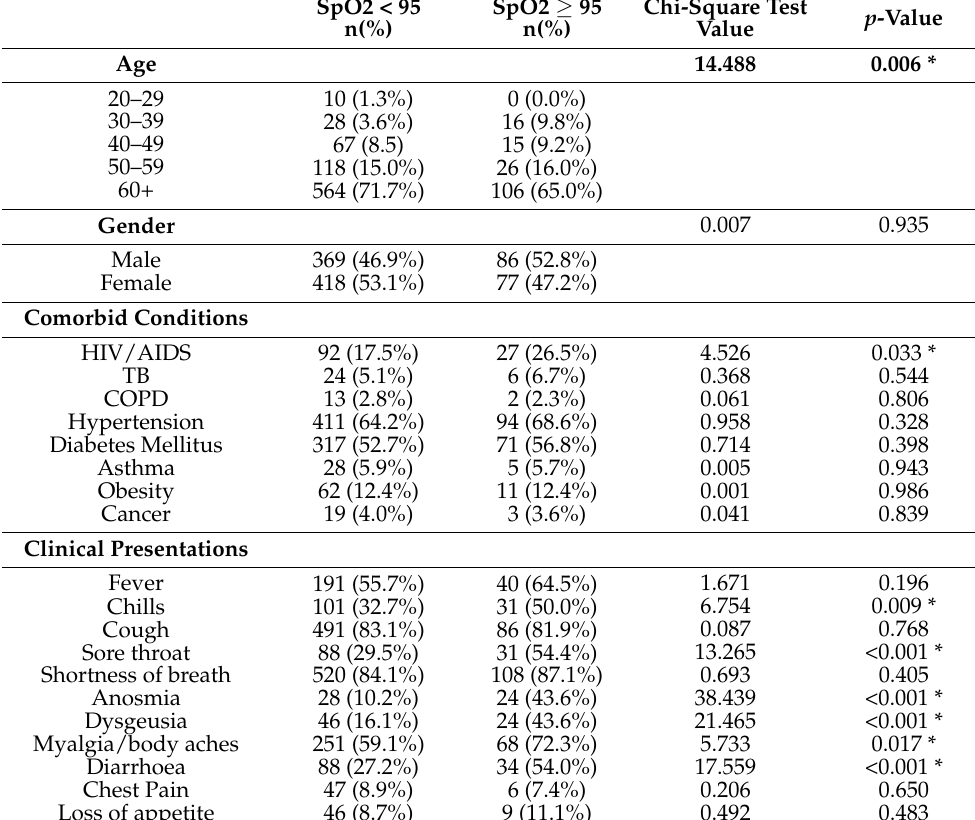
Table 2. Clinical risk factors associated with SpO2 among COVID-19 mortality patients.